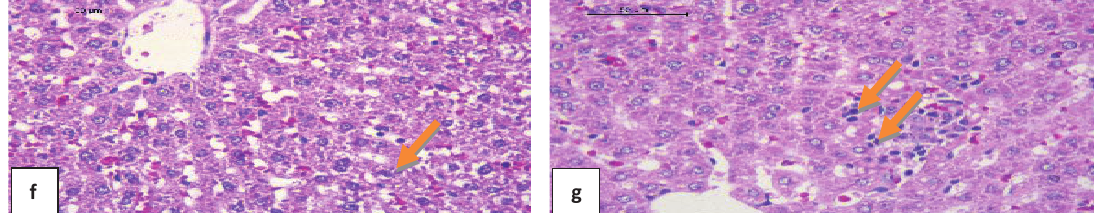
Figure 3. Histopathology of Liver Wistar rat 400x by Hematoksilin Eosin (HE). Liver damage on negative control group, shows necrosis (black circle) and vacuolization (black arrow) (d), sinusoidal dilation (red arrow) (e), and inflamatory cell (green arrow) (c).